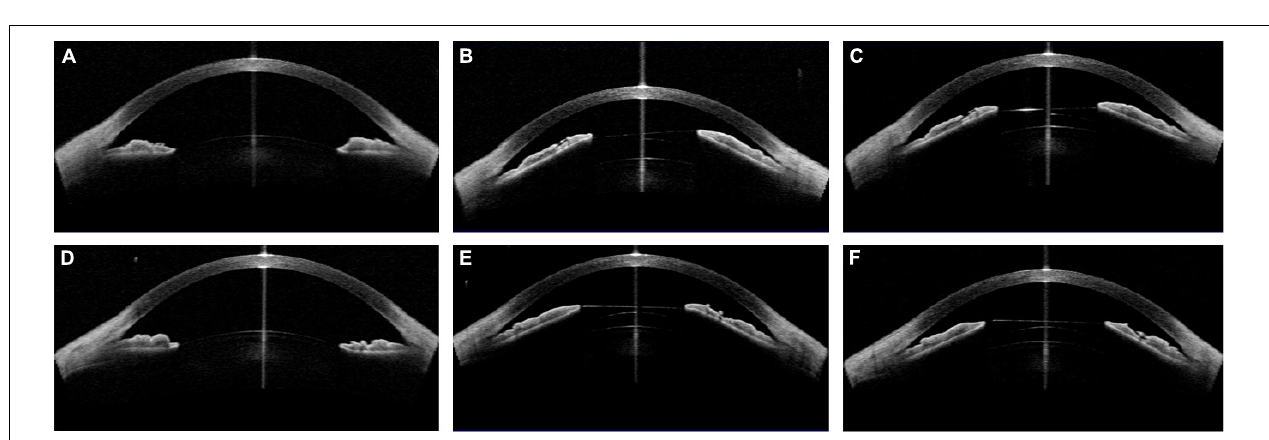
FIGURE 6 | Case 3: (A,D) Concave shape iris before surgery; (B) low vault was shown 1 day postoperatively with 121 ICL; (C) the vault was slightly increased after ICL exchange into 126 ICL 1 month postoperatively; (E) the vault of the left eye was larger than that of the right eye with 126 ICL; (F) the vault decreased 1 month postoperatively. (Row 1: right eye; Row 2: left eye).